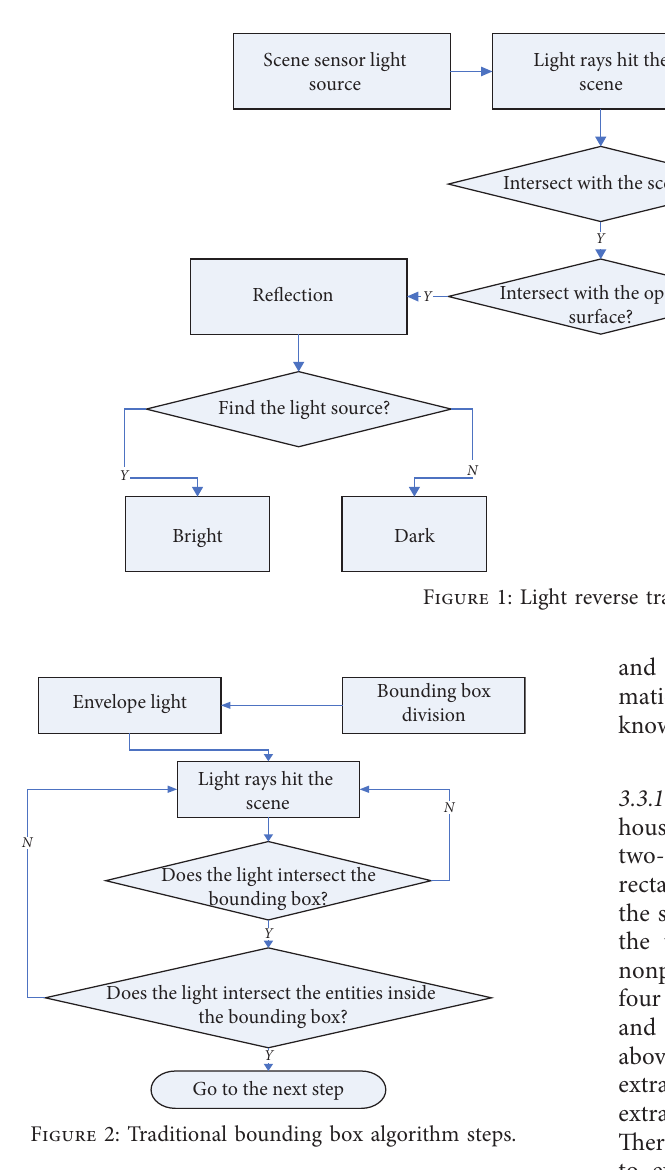
Figure 2: Traditional bounding box algorithm